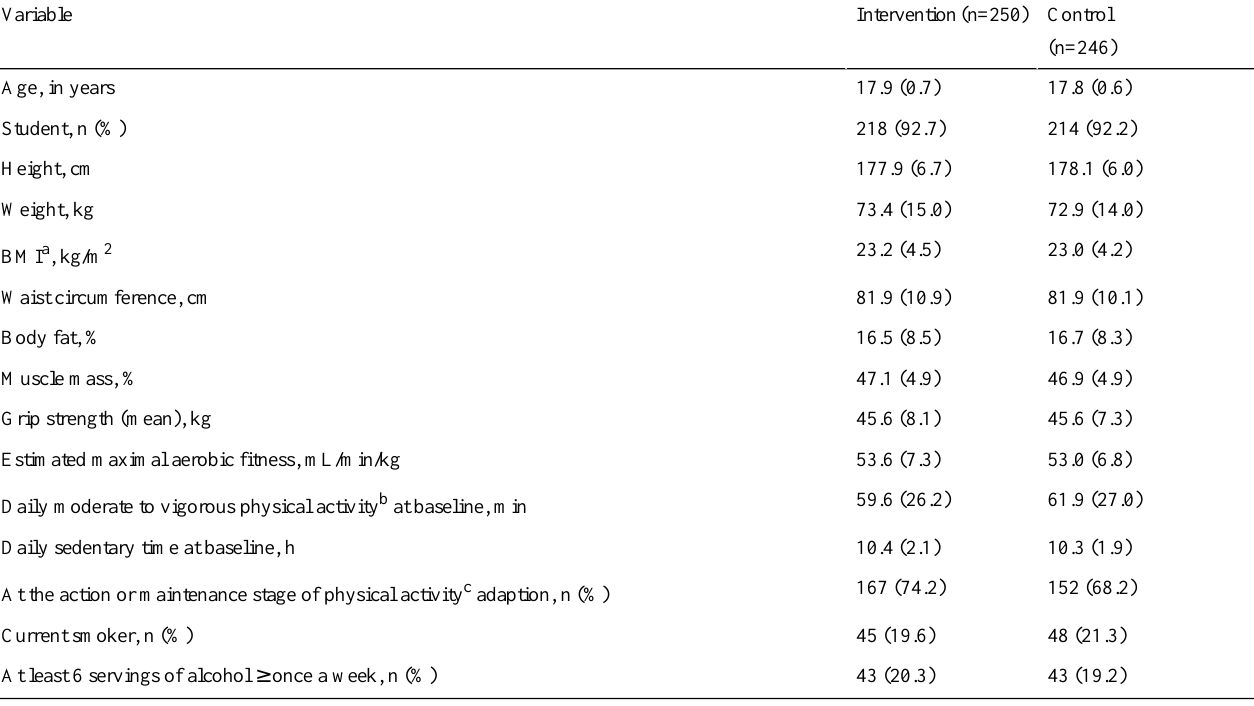
Table 1. Baseline characteristics of the study participants (N=496). Values are mean (standard deviation) unless otherwise specified. N values for the baseline moderate to vigorous physical activity and sedentary time were 87 and 80 for the intervention and control groups,